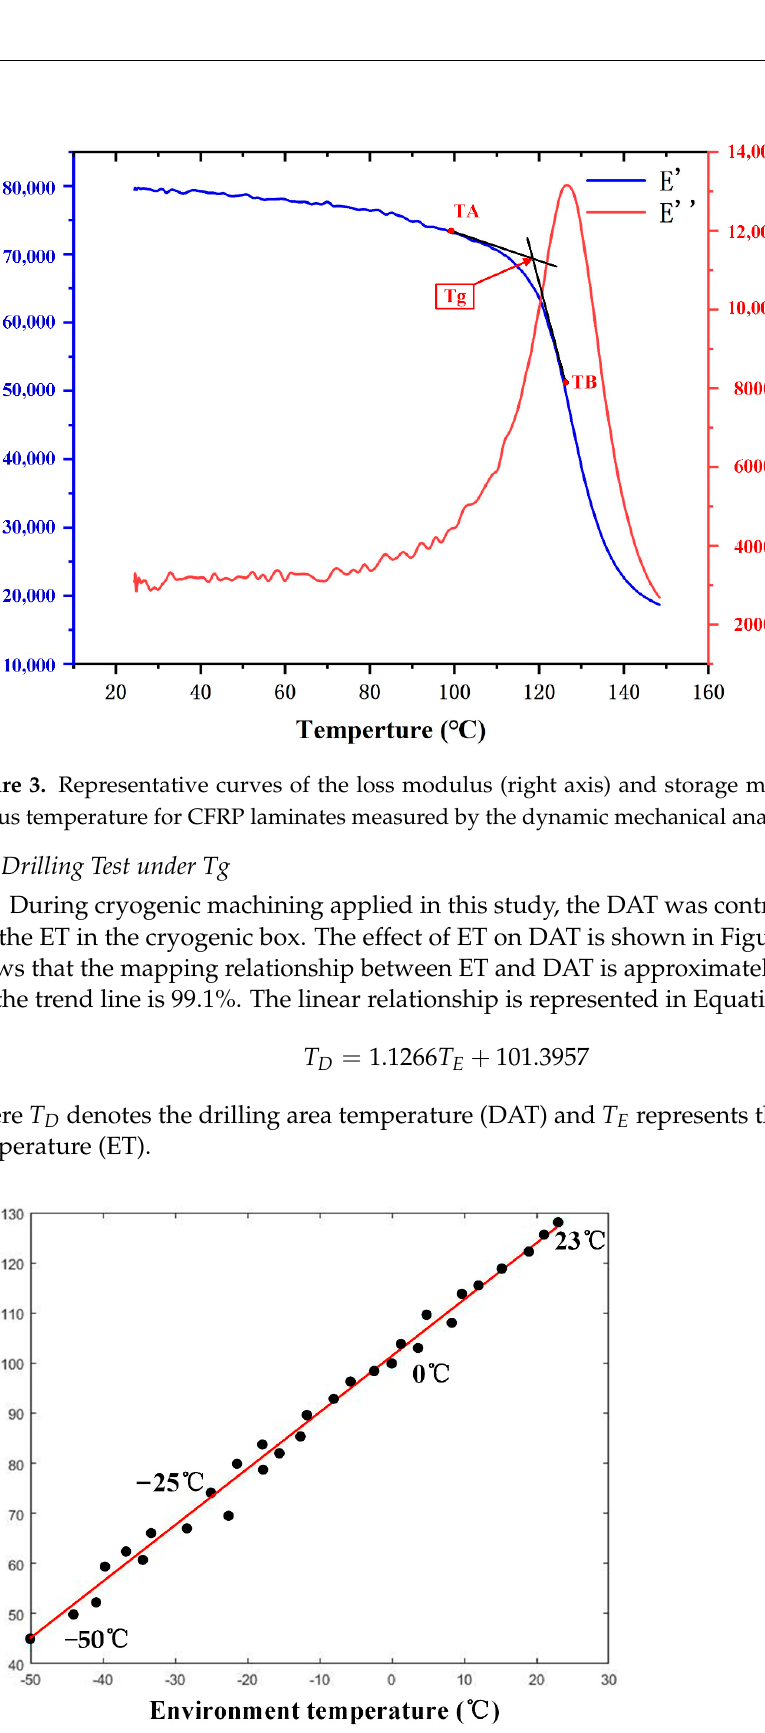
Figure 4. Mapping relationship between environment temperature (ET) and drilling area temperature (DAT).